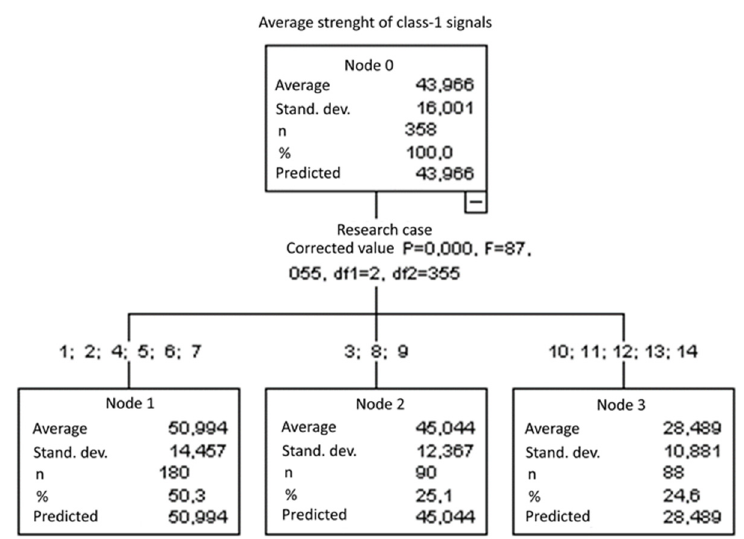
Figure 17. Classification tree for the average strength of class-1 signals.